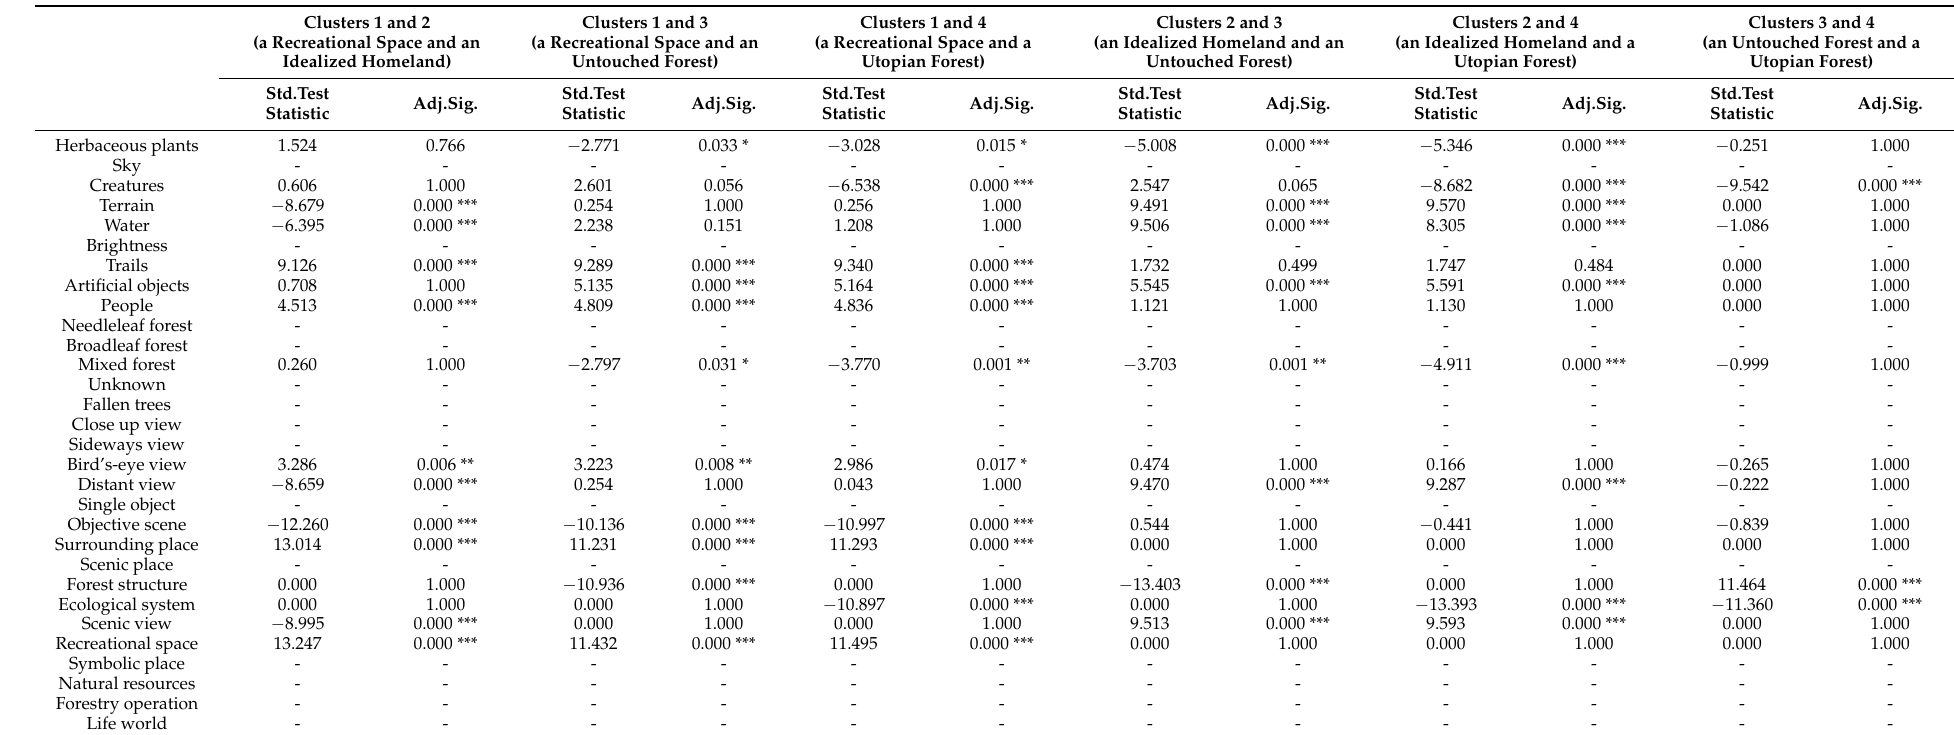
Table 3. The pairwise comparisons of each